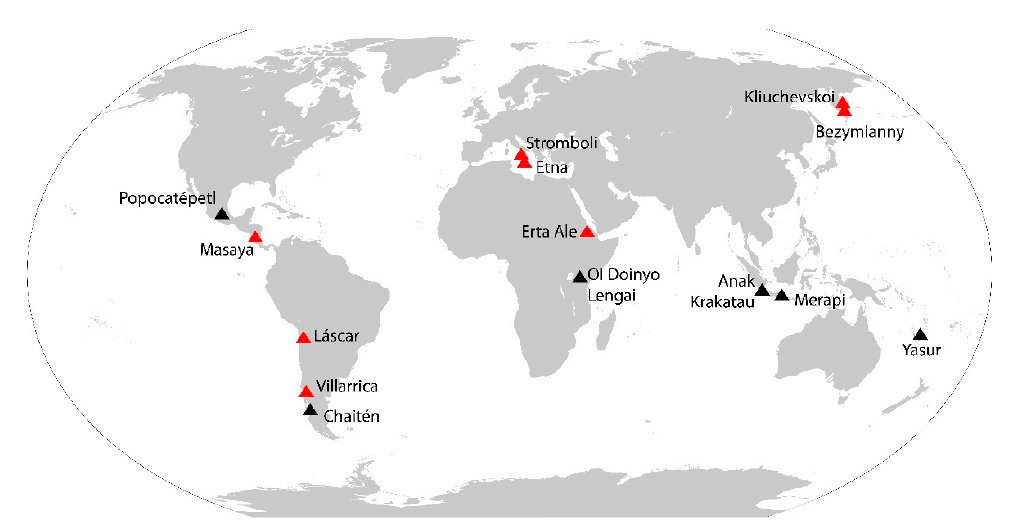
Figure 1. Geographic locations of volcanoes investigated in this work. With black triangles are indicated examples of algorithm applications presented in this work; with red triangles the case studies on which MSI SENTINEL-2 and MODIS–MIROVA 2016–2019 timeseries are here shown.